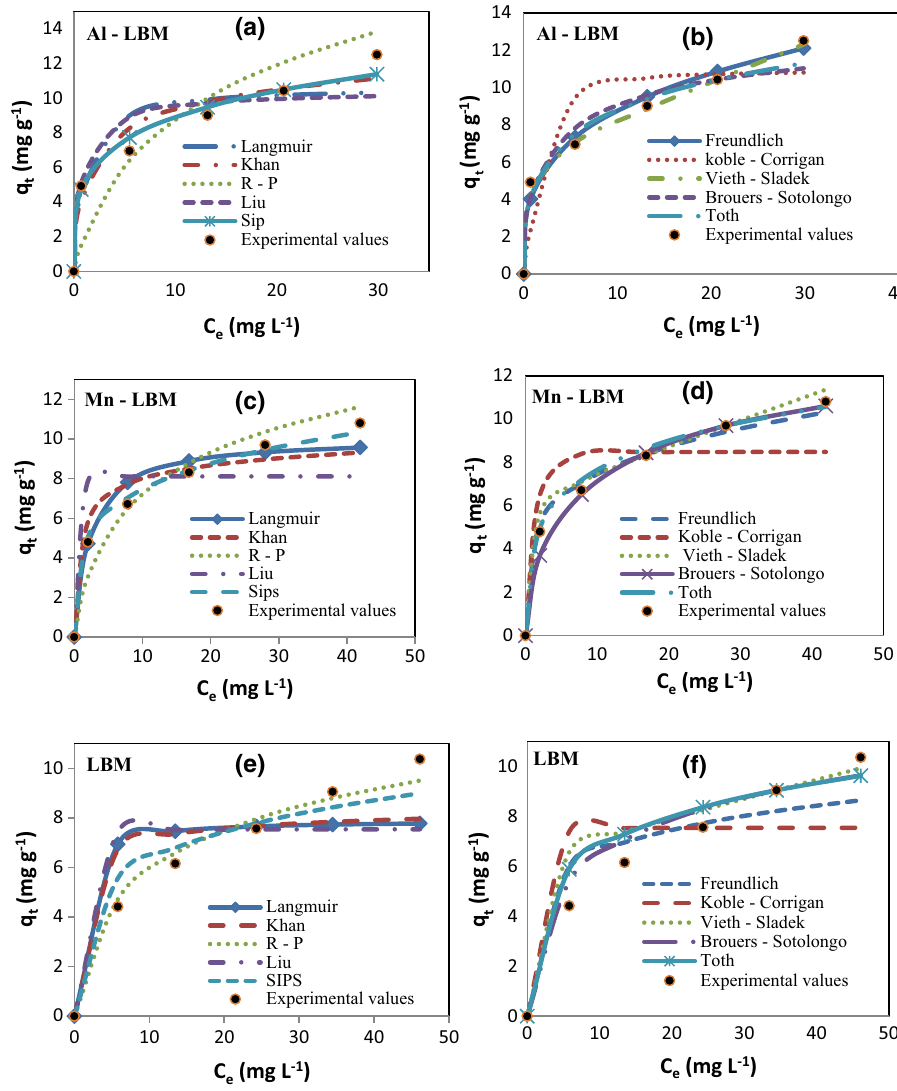
Fig. 2 Fits of the isotherm models for Al-LBM ( a , b ), Mn- LBM ( c , d ) and LBM ( e , f